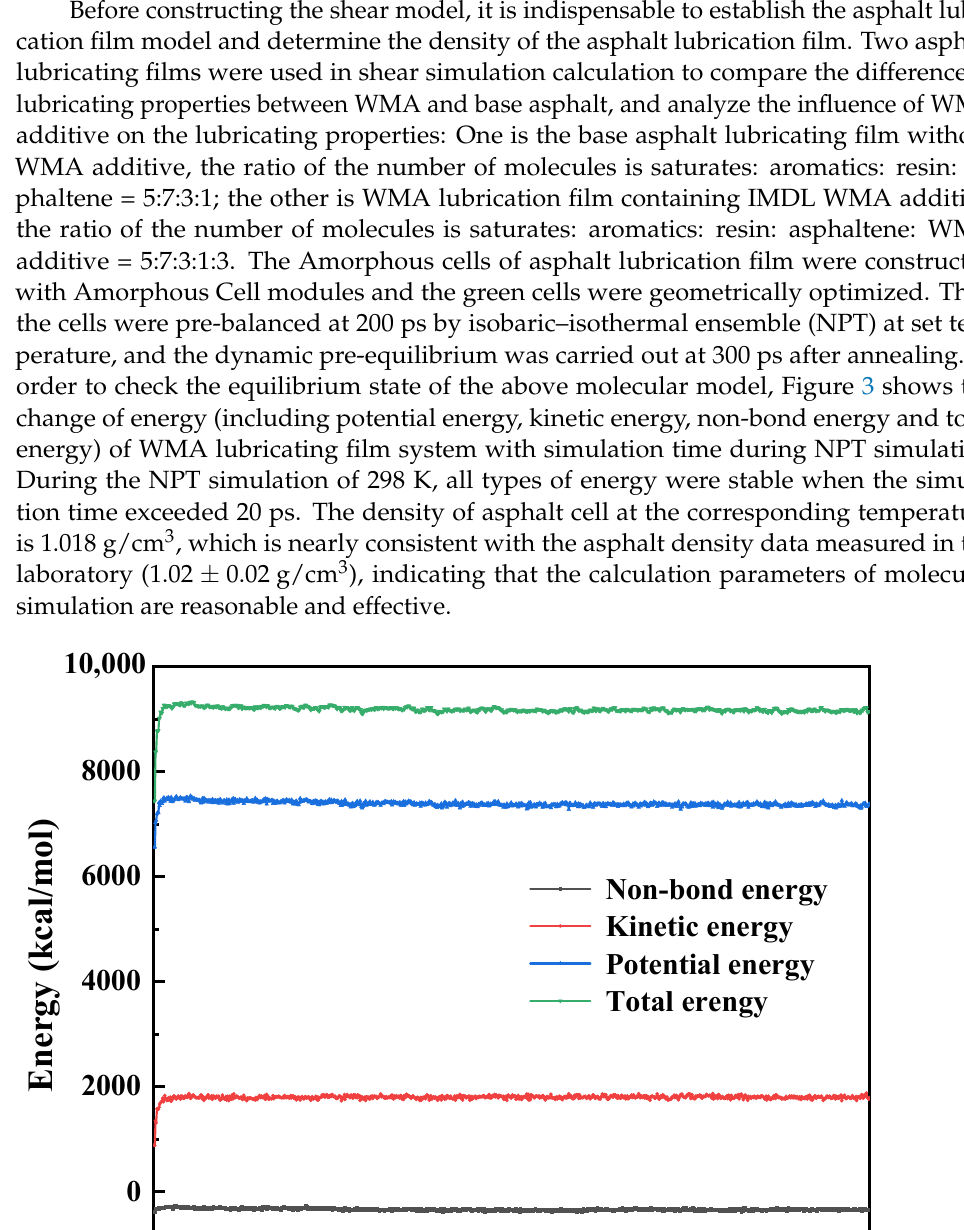
6 of 19 Figure 2. The optimized models: ( a ) asphalt SARA four fractions; ( b ) imidazoline surfactants WMA additives; ( c ) calcite (104) surface. 2.2. Details of MD Simulation 2.2.1. Construction of Asphalt Lubricating Film Cell Before constructing the shear model, it is indispensable to establish the asphalt